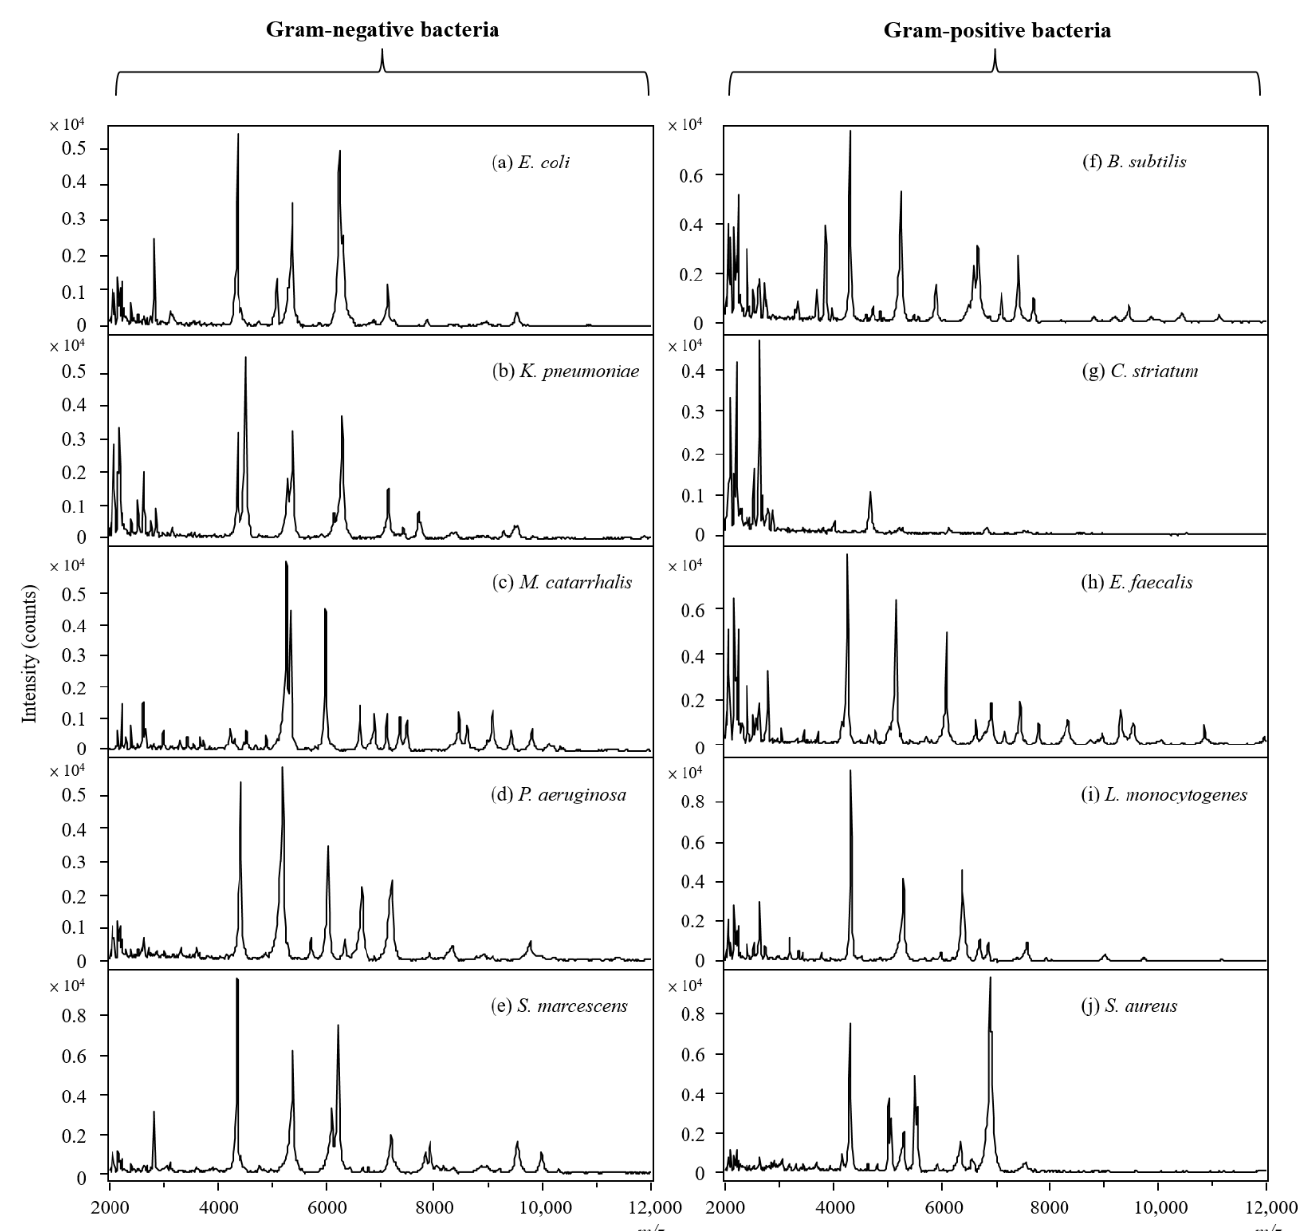
Figure 6. MALDI mass spectra recorded in positive mode for Gram-negative bacteria: ( a ) E. coli , ( b ) K. pneumonia , ( c ) M. catarrhalis , ( d ) P. aeruginosa , and ( e ) S. marcescens . MALDI mass spectra recorded in positive mode for Gram-positive bacteria: ( f ) B. subtilis , ( g ) C. striatum , ( h ) E. faecalis , ( i ) L. monocytogenes , and ( j ) S. aureus .